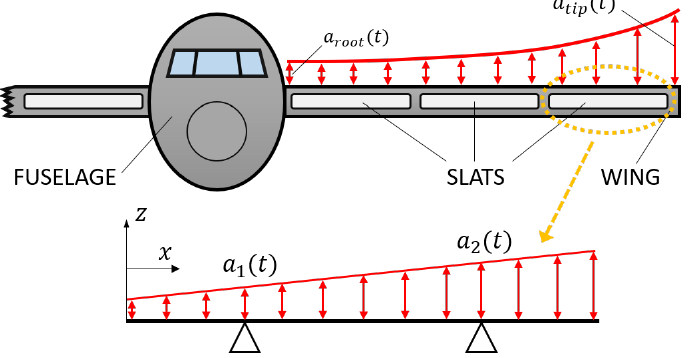
Figure 5. Expected trend of the acceleration along a wing with slats. The distribution of the accelera- tion along the single slat is a linear function of the x